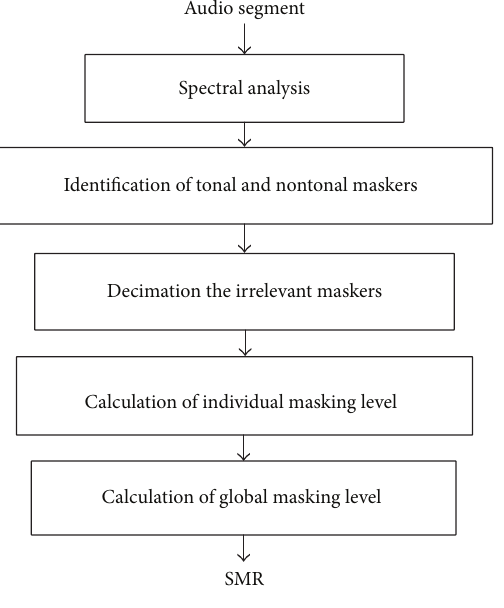
Figure 3: Psychoacoustic model 1 .